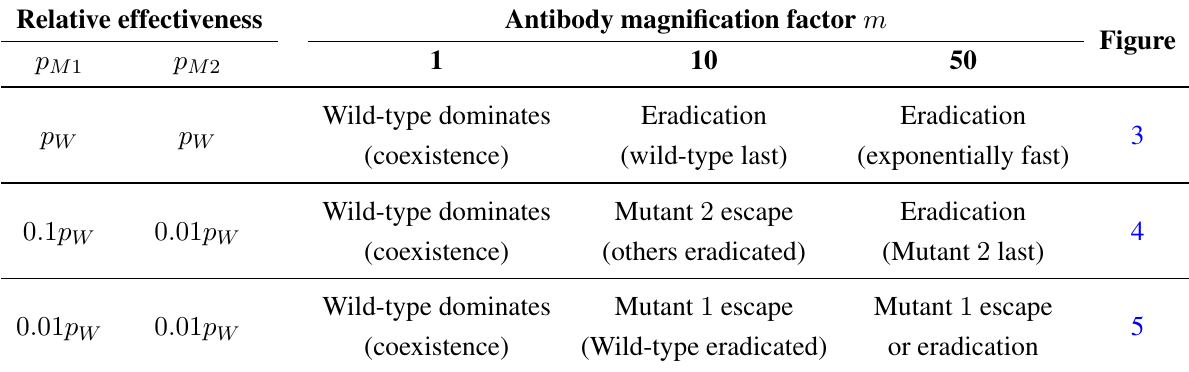
Table 2. The outcomes from changing antibody infusion and relative effectiveness.